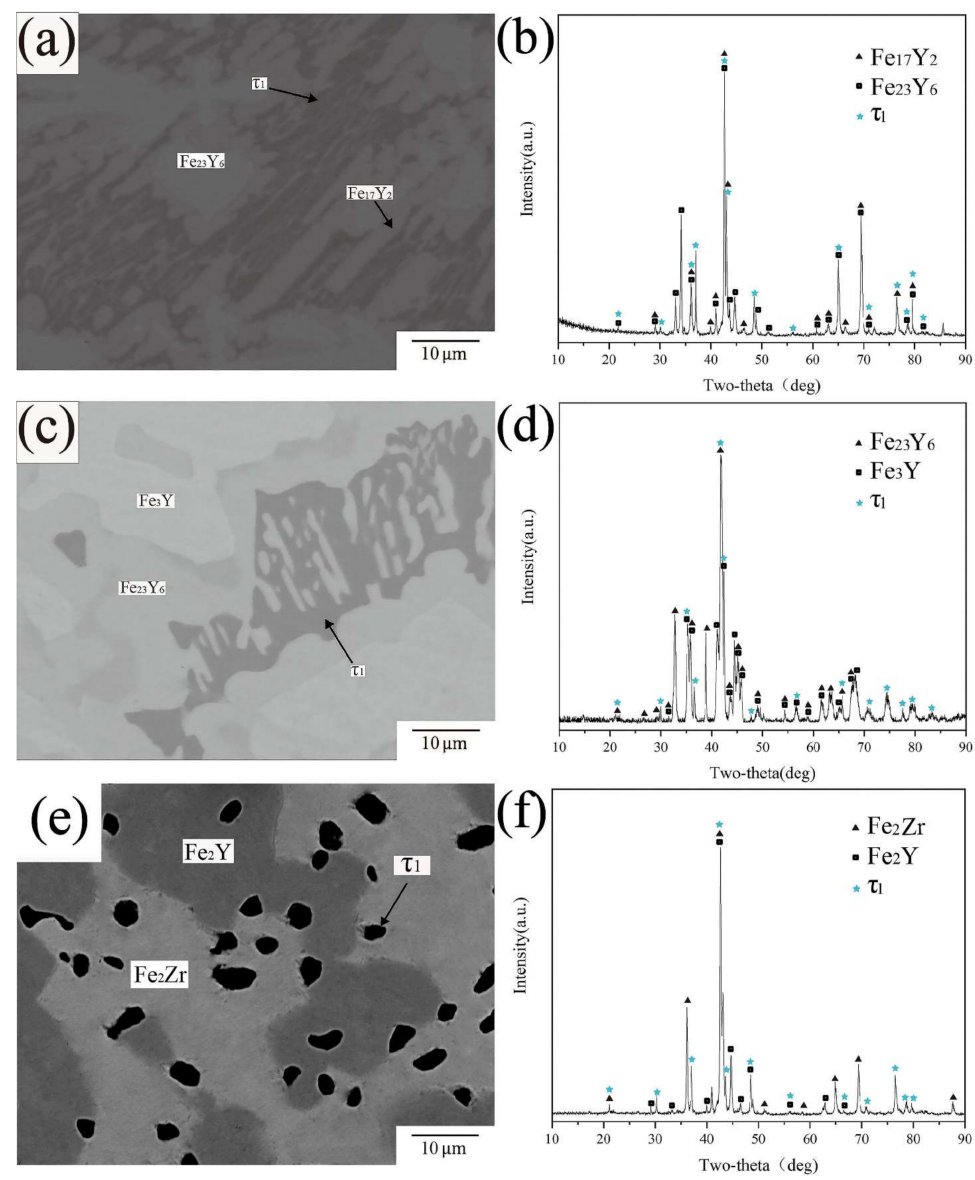
Figure 9. ( a ) BSE image of A5 ( b ) XRD pattern of A5 ( c ) BSE image of A17 ( d ) XRD pattern of A17 ( e ) BSE image of A10 ( f ) XRD pattern of